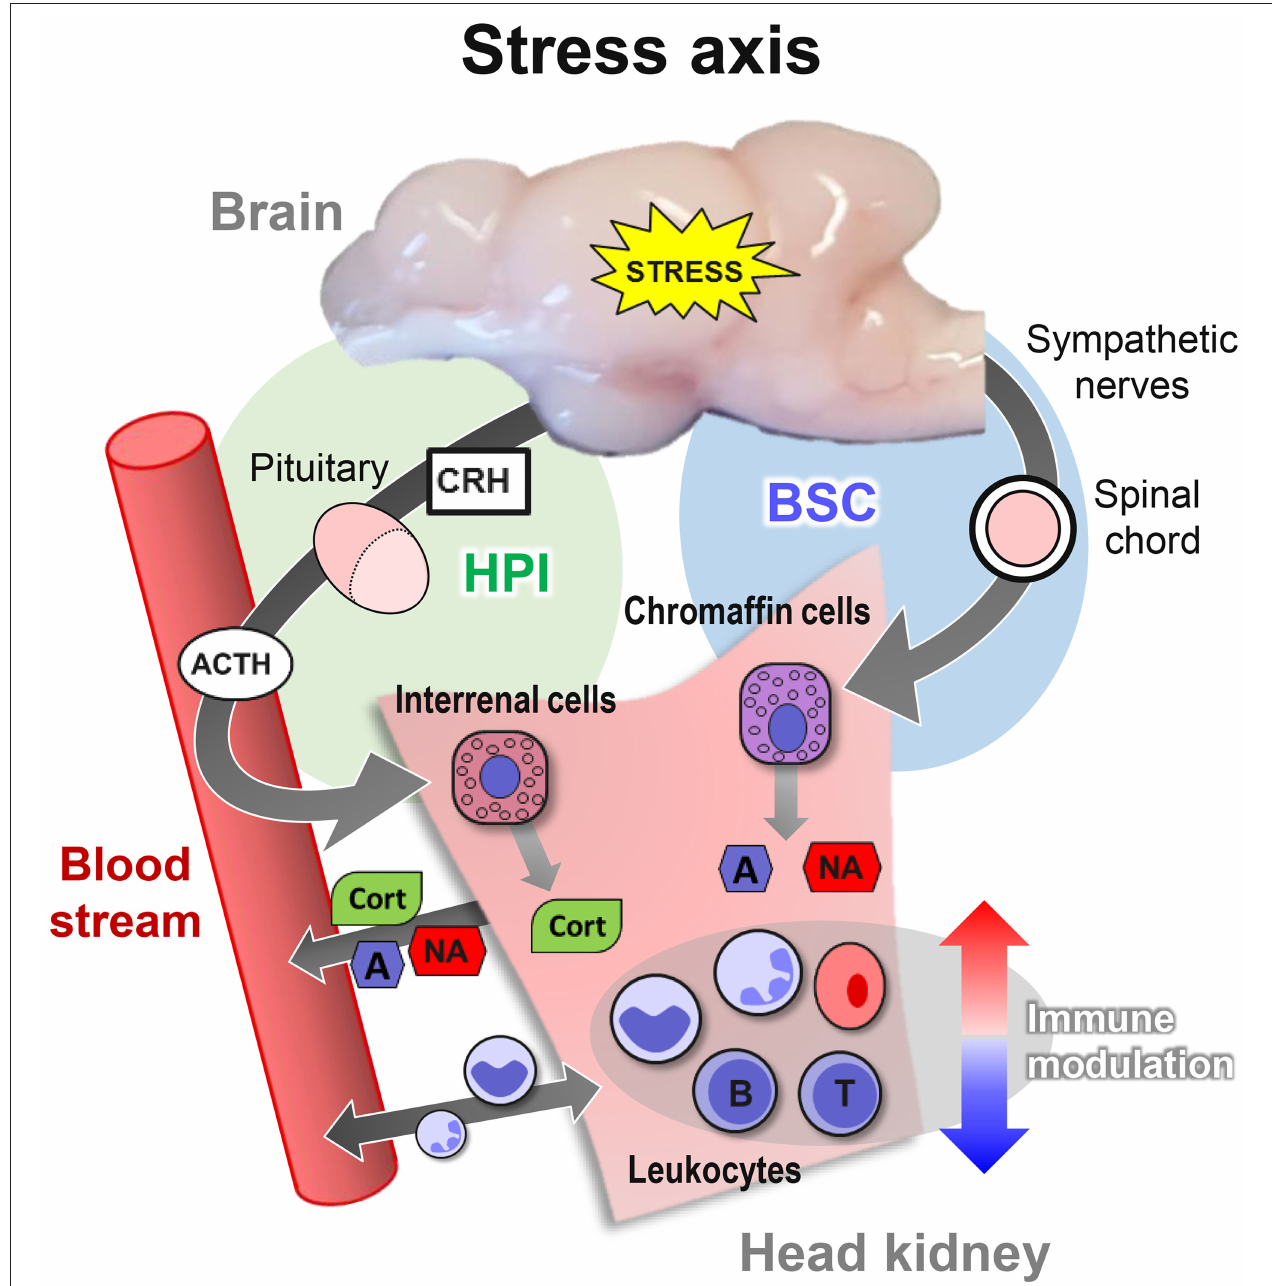
FIGURE 1 | Overview of the three levels of the stress response in teleost fish. The primary response activates the brain-sympathetic-chromaffin (BSC) axis. Sympathetic nerve fibers transfer the stress signals through the spinal cord and the sympathetic ganglia, which innervate and form synapses with chromaffin cells in the head kidney. The synapse activity triggers the release of the catecholamines adrenaline (A) and noradrenaline (NA) into the bloodstream. In parallel, the activation of the hypothalamic–pituitary–interrenal (HPI) axis stimulates the release of corticotropin-releasing hormone (CRH) and adrenocorticotropic hormone (ACTH) into the blood. ACTH, in turn, induces the interrenal cells in the head kidney to release cortisol (CORT) into the bloodstream. CORT promotes the secondary response of reorganizing the availability of energy resources, as reflected by altered blood pressure and heart rate and by the changed concentrations of glucose and lactate. The tertiary response is reached when the system assumes a dysregulated state but cannot return to homeostasis, thereby impairing the immune system, behavior, growth, and reproduction. “single 1-min handling” and sampled 3 h post-treatment ( n isolation of head-kidney cells followed our previously = 4) and in samples from matching controls ( n = 4). The